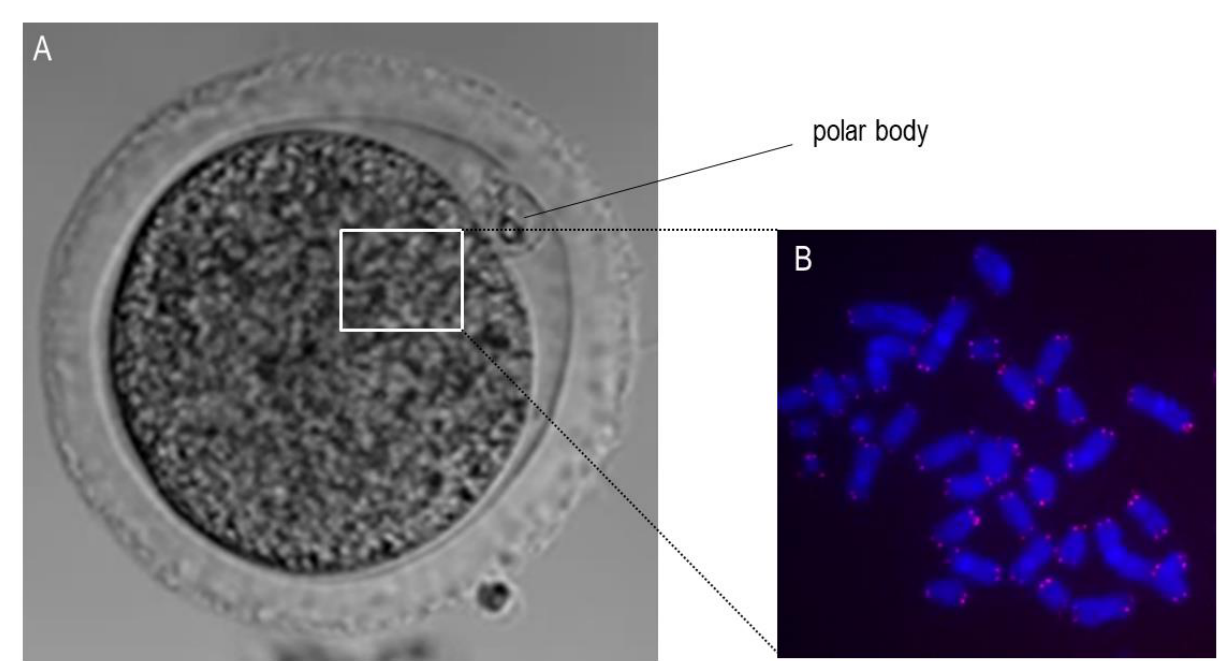
Figure 2. Microscopic visualization of the metaphase II oocyte and chromosomes. ( A ): This panel shows an exemplary